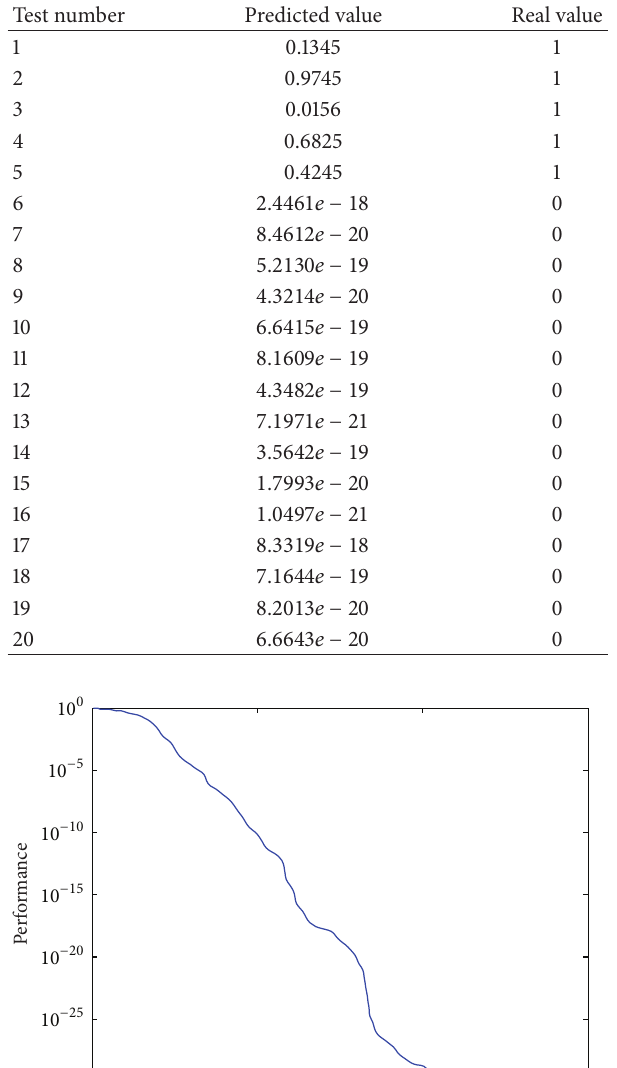
Table 1: The Douglas-1 test results of the RBFNN trained by Douglas-1.